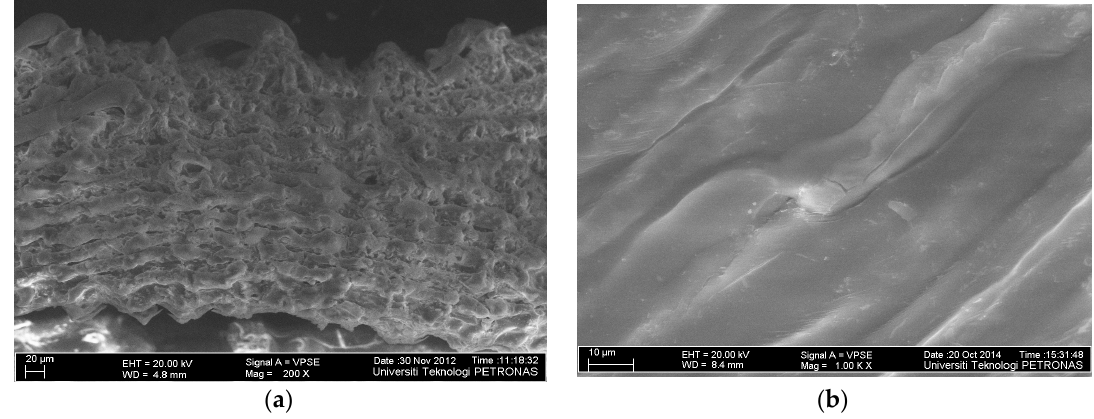
Figure 2. Scanning electron microscopy (SEM) images of ( a ) RHC4 and ( b ) Cu(II)-loaded RHC4 (adsorbent dose: 8 g/L, Cu(II) concentration: 80 mg/L, contact time: 120 min).